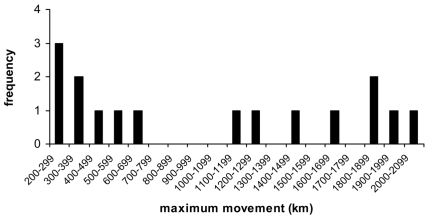
Frequency of migrants across a distance gradient in vespertilionid bats.This graph shows short-distance migrants generally move between 100 and 600 km and long-distance migrants moved between 1000 and 2000 km [8].